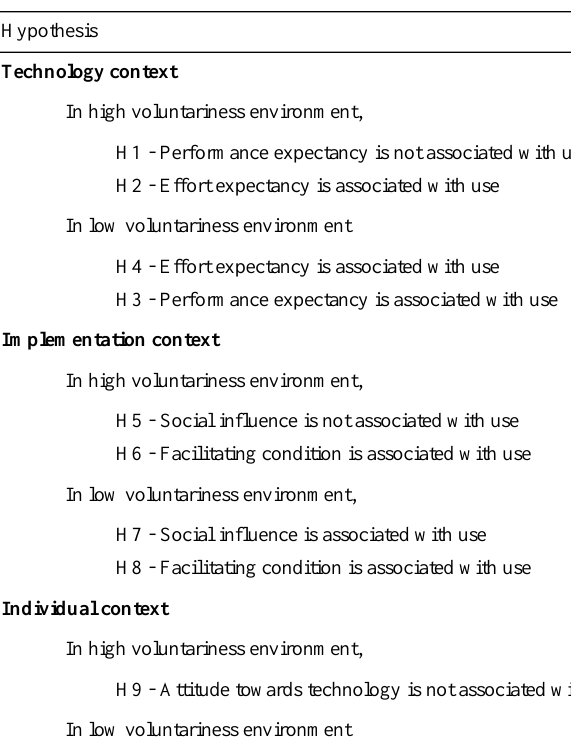
Table 1. Hypotheses of moderating effects of voluntariness on technology, implementation, and individual contexts.